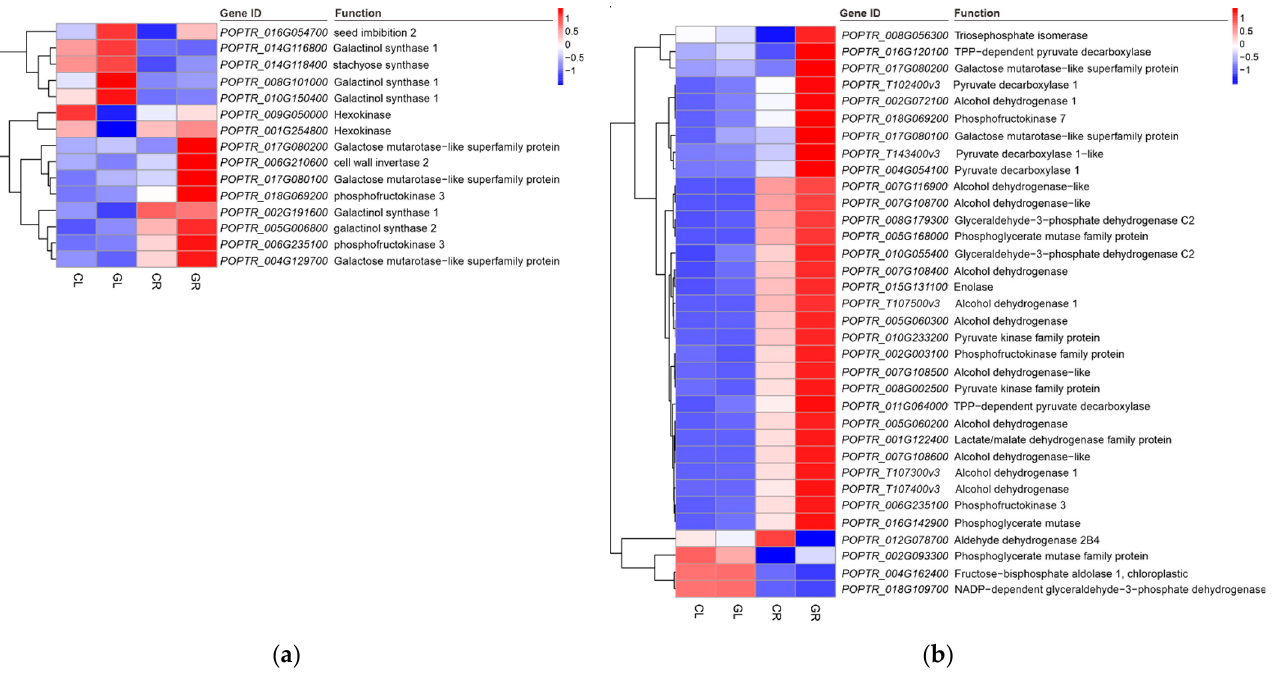
Figure 8. Expression pattern analysis of DEGs in galactose metabolism ( a ) and glycolysis/glucone- ogenesis pathway ( b ) by the pairwise comparisons of GL vs CL and GR vs CR. CL, CR, GL and GR represent the shoots and roots samples of the inorganic N control and the Gln treatment, respec- tively.